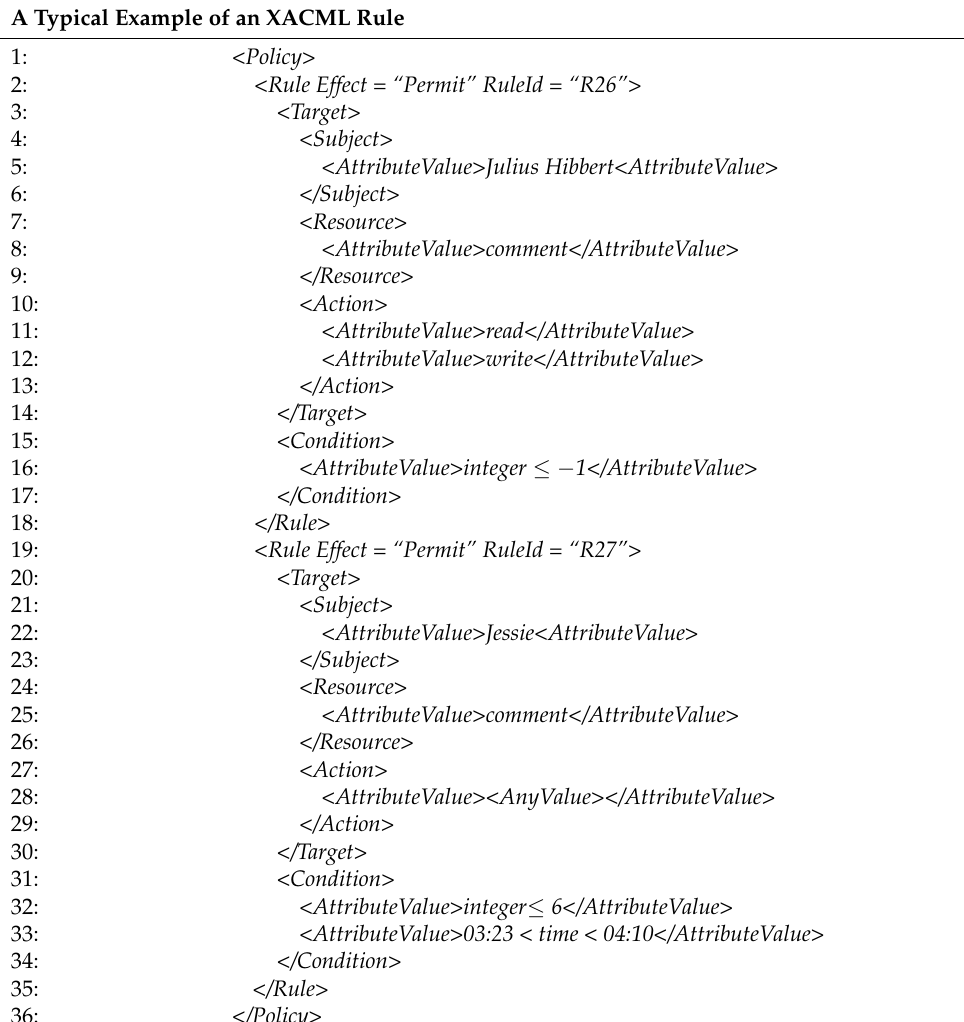
Table 1. A Segment of an XACML Policy. A Typical Example of an XACML Rule